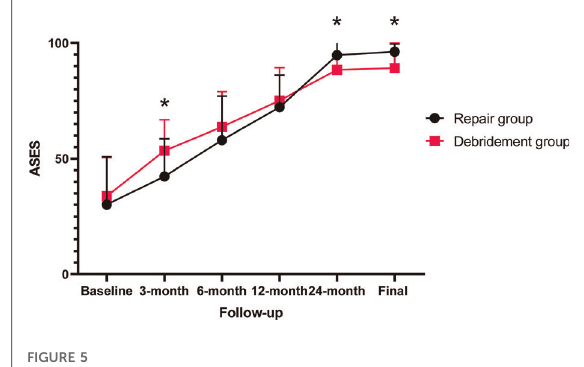
FIGURE 5 Postoperative ASES scores of the two subgroups at different follow- up